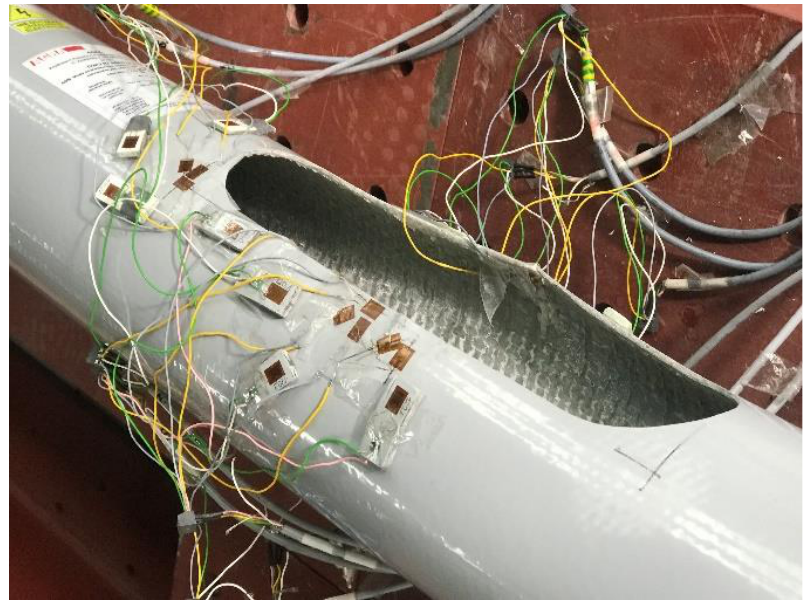
Figure 6. Visible damage to pole no. 5/2 in the area of the inspection opening.